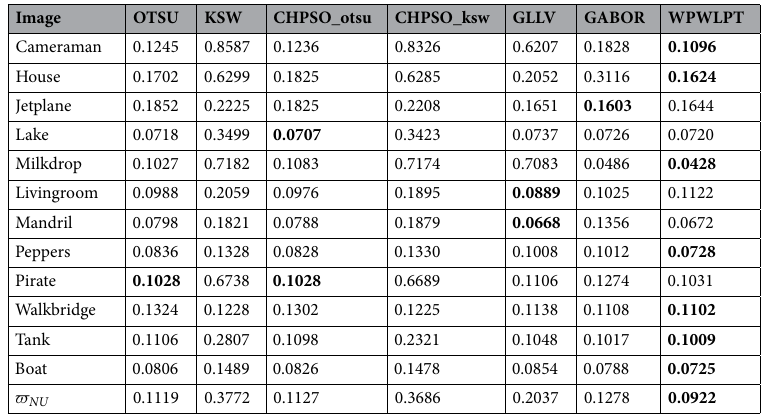
Table 6. NUs of the different thresholding methods. The best results are highlighted in bold.